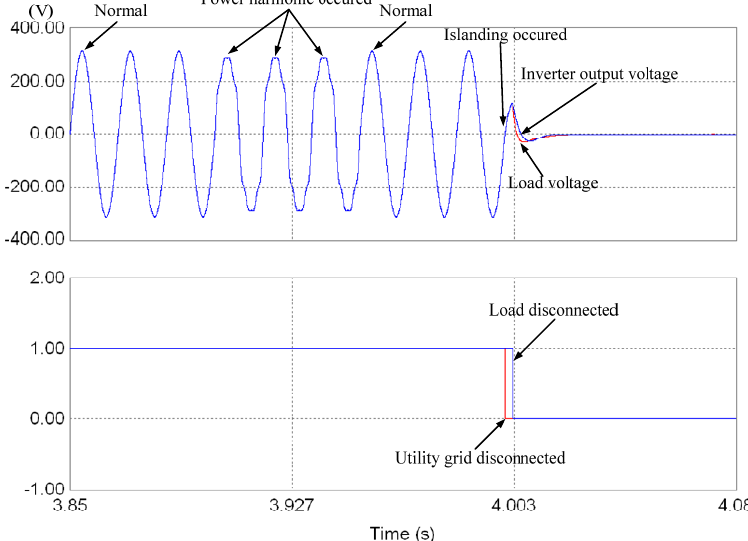
Figure 8. Simulation diagram of islanding detection influenced by power harmonics.